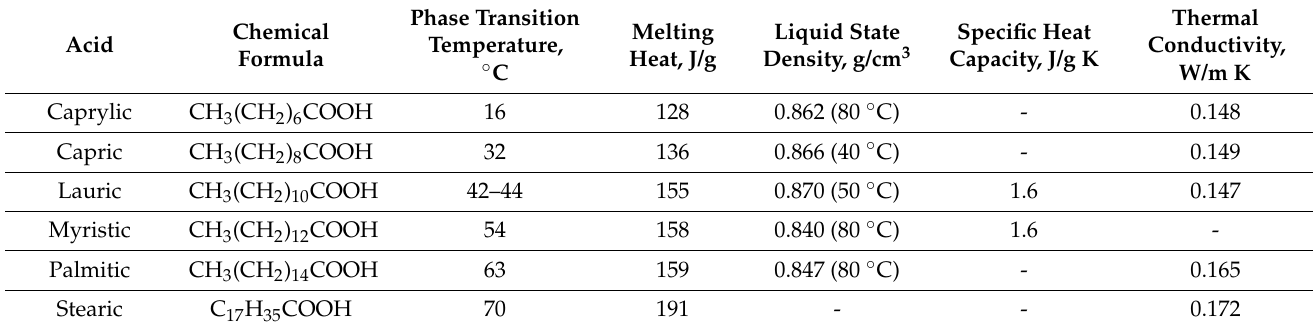
Table 2. Thermophysical properties of fatty acids [27].